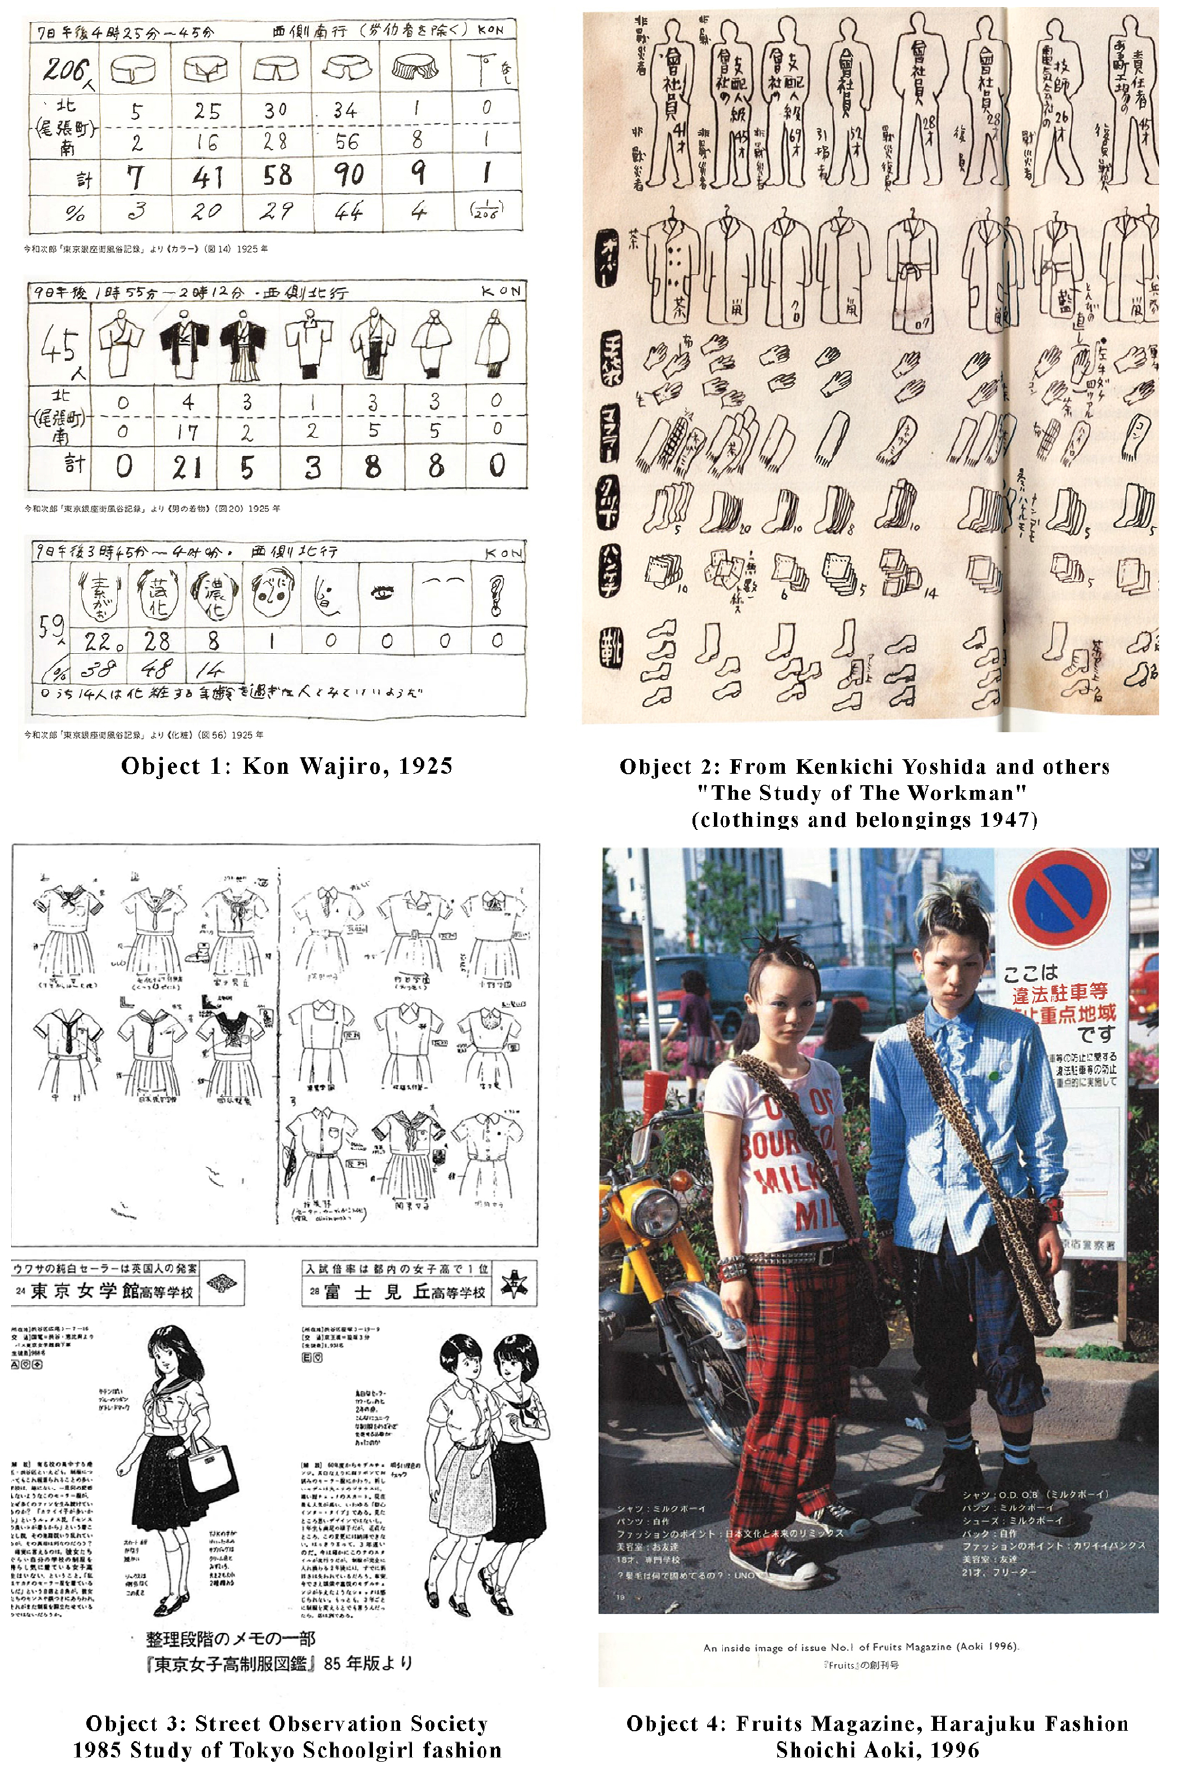
Trajectory of fashion observations, documented by different individuals in 1925, 1947, 1985 and 1996